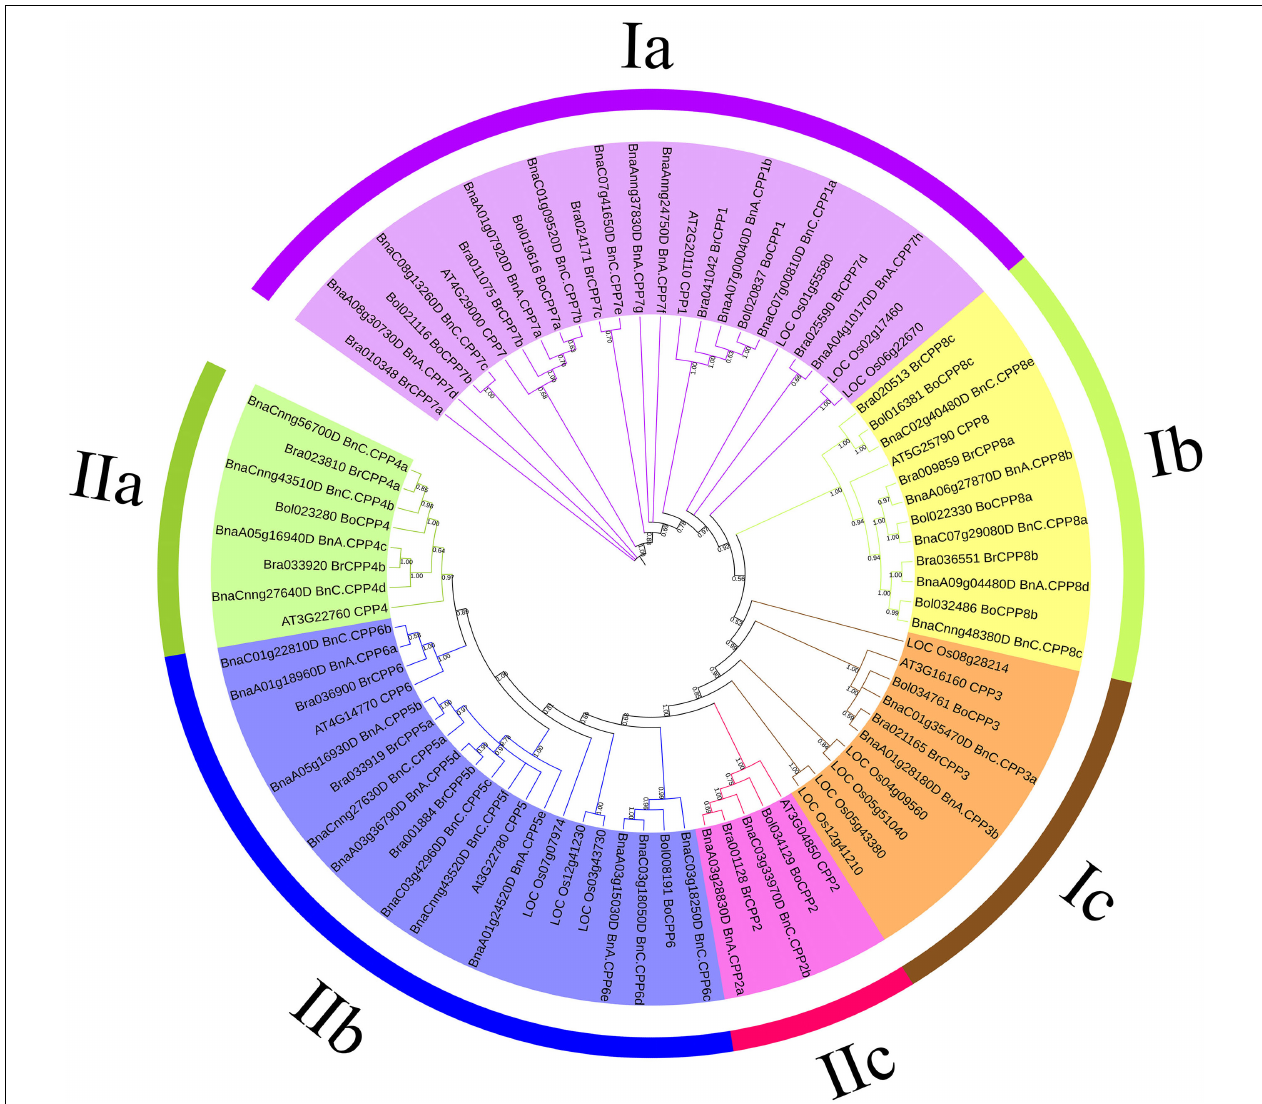
FIGURE 3 | Phylogenetic tree of CPP proteins in B. napus, B. rapa, B. oleracea, Arabidopsis thaliana, and Oryza sativa . The prefixes Bra, Bol, Bna, AT, and LOC stand for B. rapa , B. oleracea , B. napus , A. thaliana and O. sativa , respectively. Only bootstrap values greater than 50% were displayed. All CPP proteins were divided into two clades (I,II) and six subclades